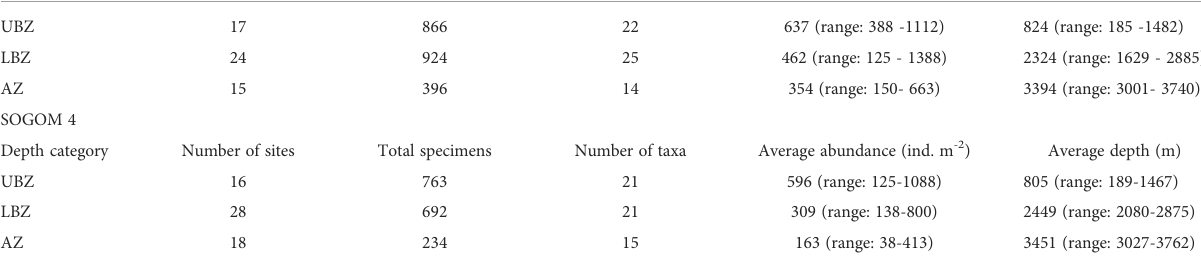
TABLE 2 Number of sites, specimens, and taxa. Average abundance, and depth for each depth category of each